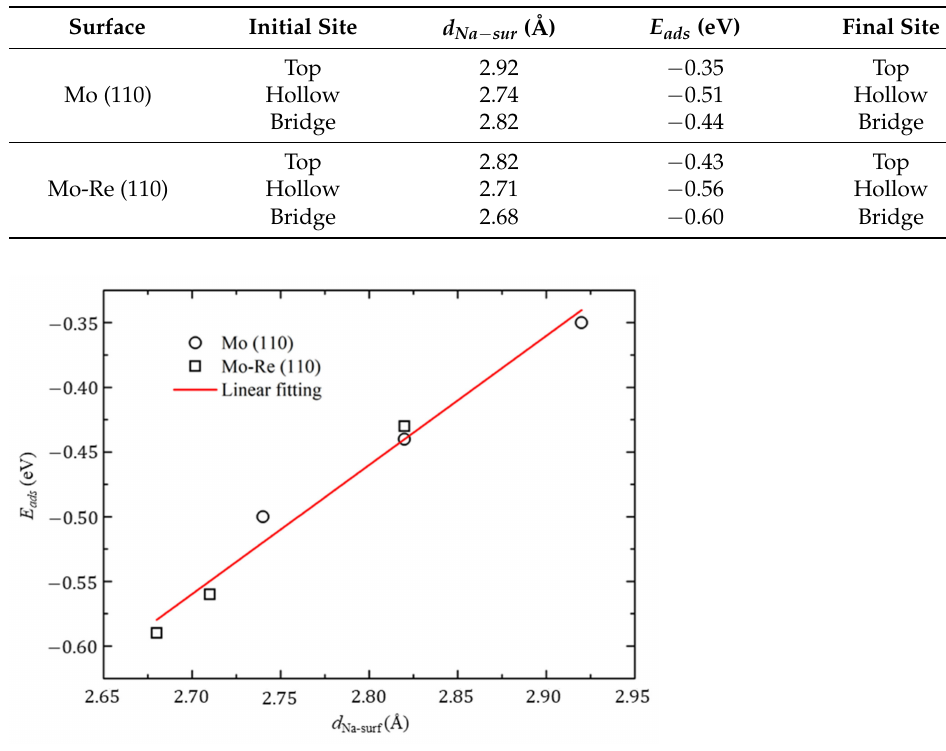
Figure 3. Na adsorption energy as the function of the average distance between the Na atom and the top layer of the substrate.